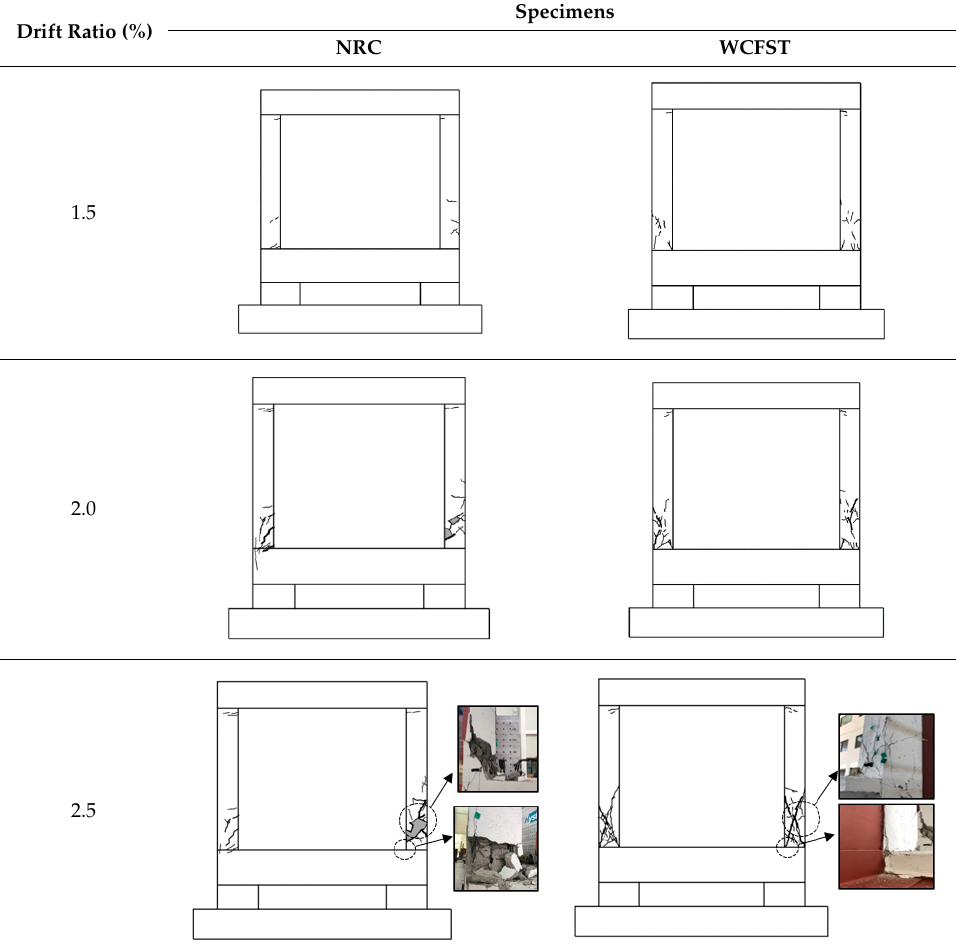
Table 2. Crack patterns and failure in the specimens.